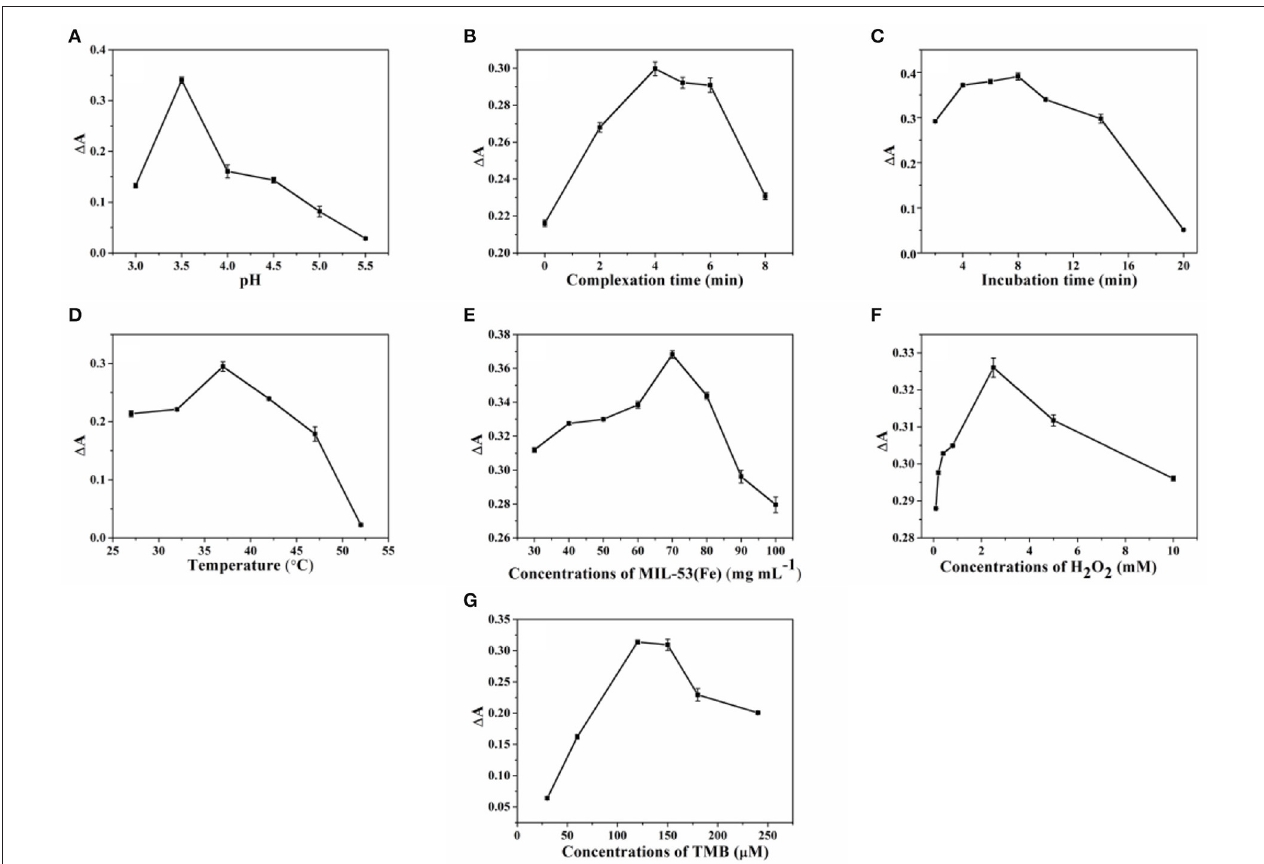
FIGURE 5 | The optimization of (A) pH, (B) complexation time, (C) incubation time, (D) temperature, and concentrations of (E) MIL-53(Fe), (F) H 2 O 2 , and (G) TMB for SA sensing. Error bars represent the standard deviation of the three trials.